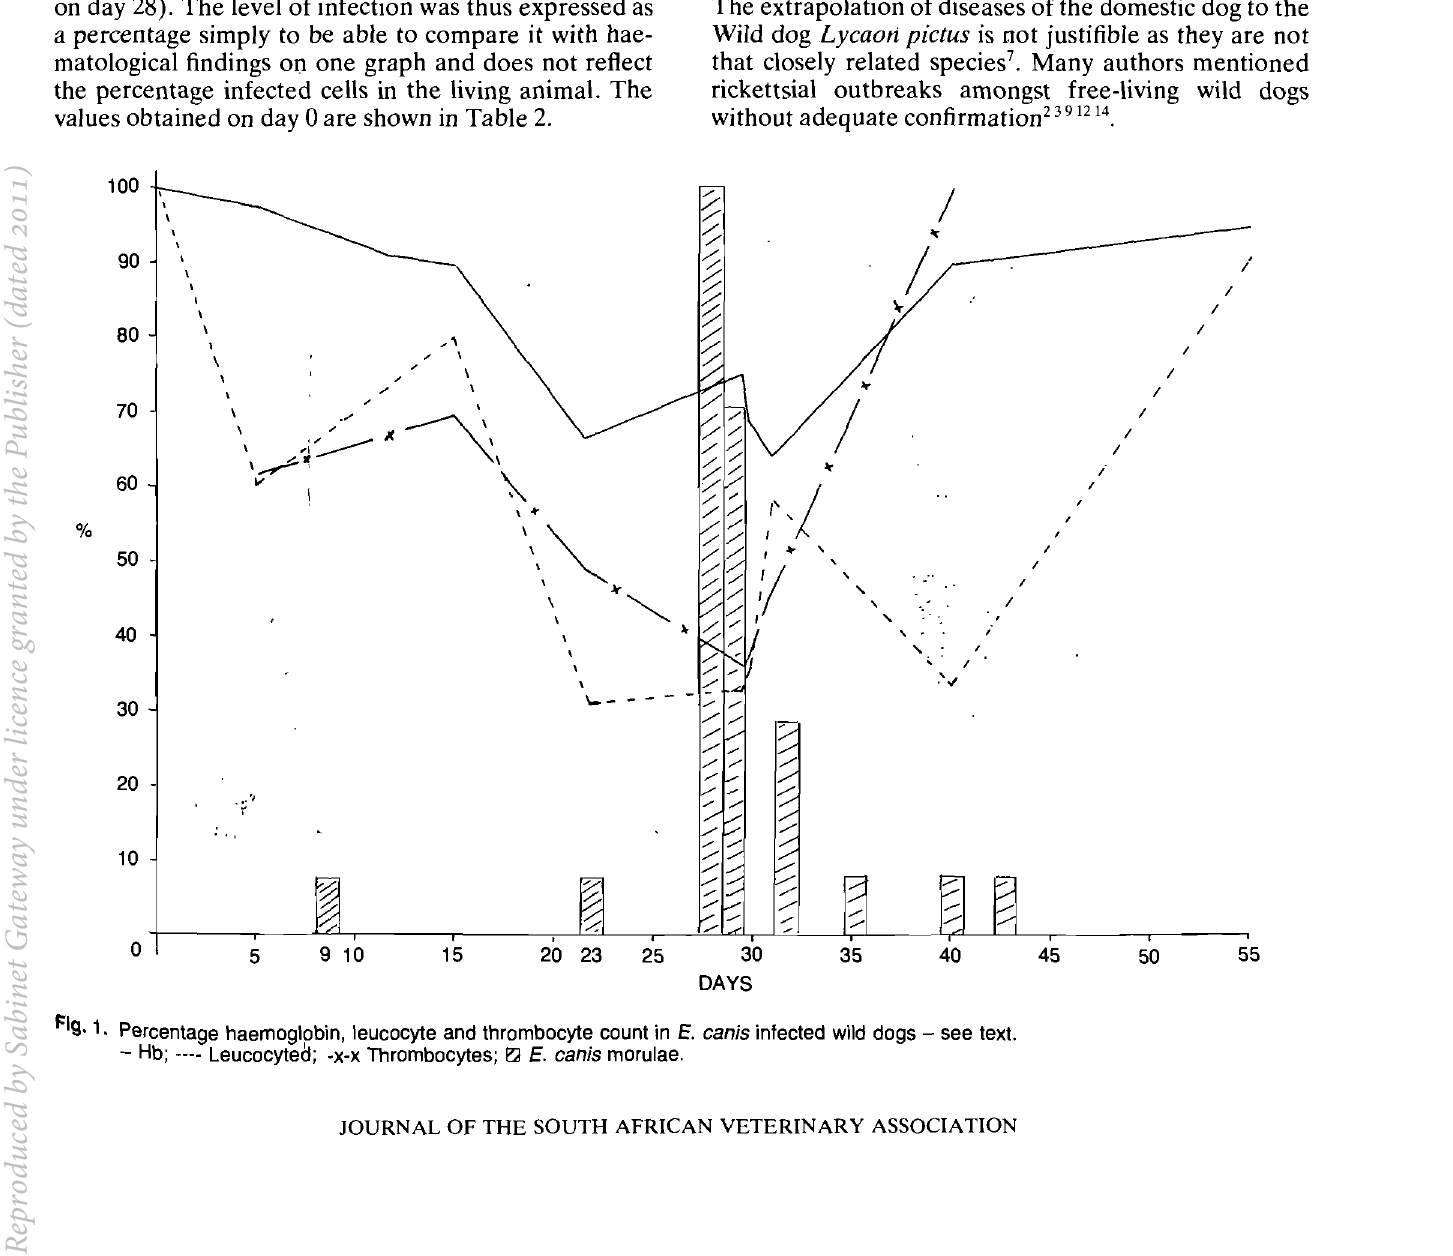
JOURNAL OF THE SOUTH AFRICAN VETERINARY